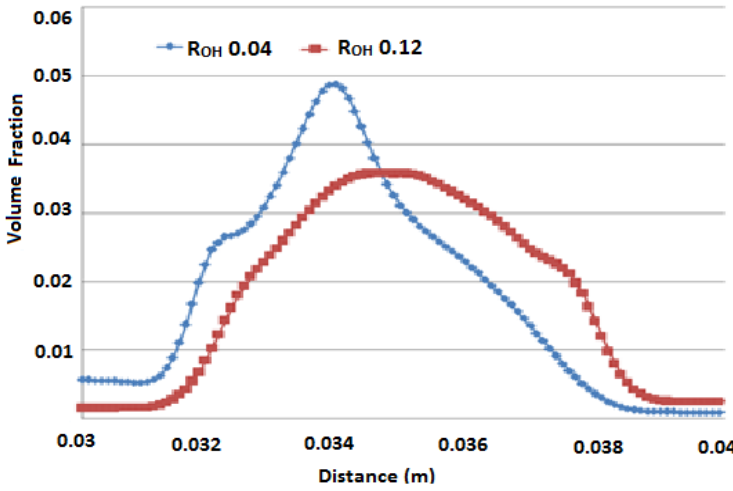
Figure 9. Comparison of solid phase volume fraction for the different rotational speed of inner wall at constant linear velocity [R OH =0.04 (70 RPM); R OH =0.12 (200